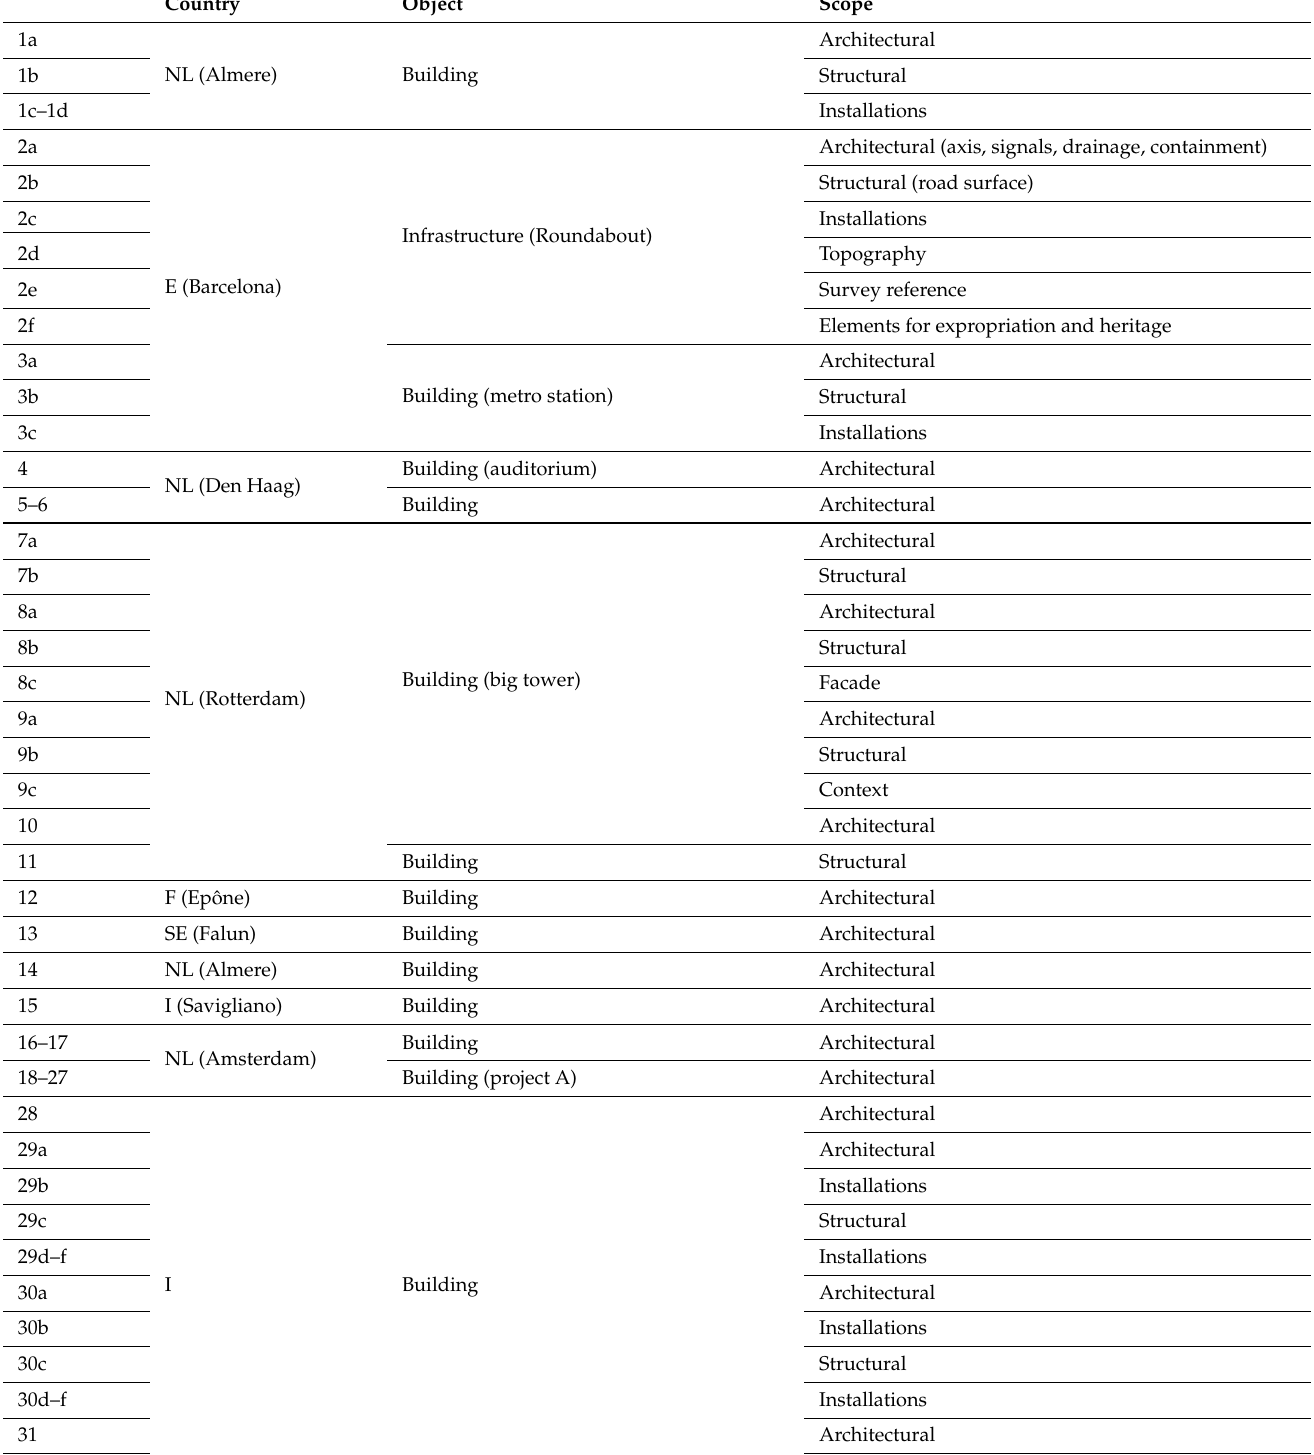
Table 2. Synthesis features of the models